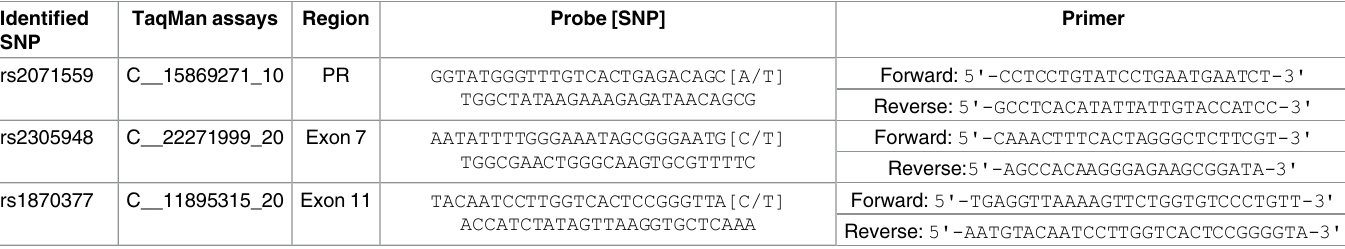
Table 1. Characterization of KDR polymorphisms, probes and primers sequences for genotyping by TaqMan real time PCR. Identified TaqMan assays SNP